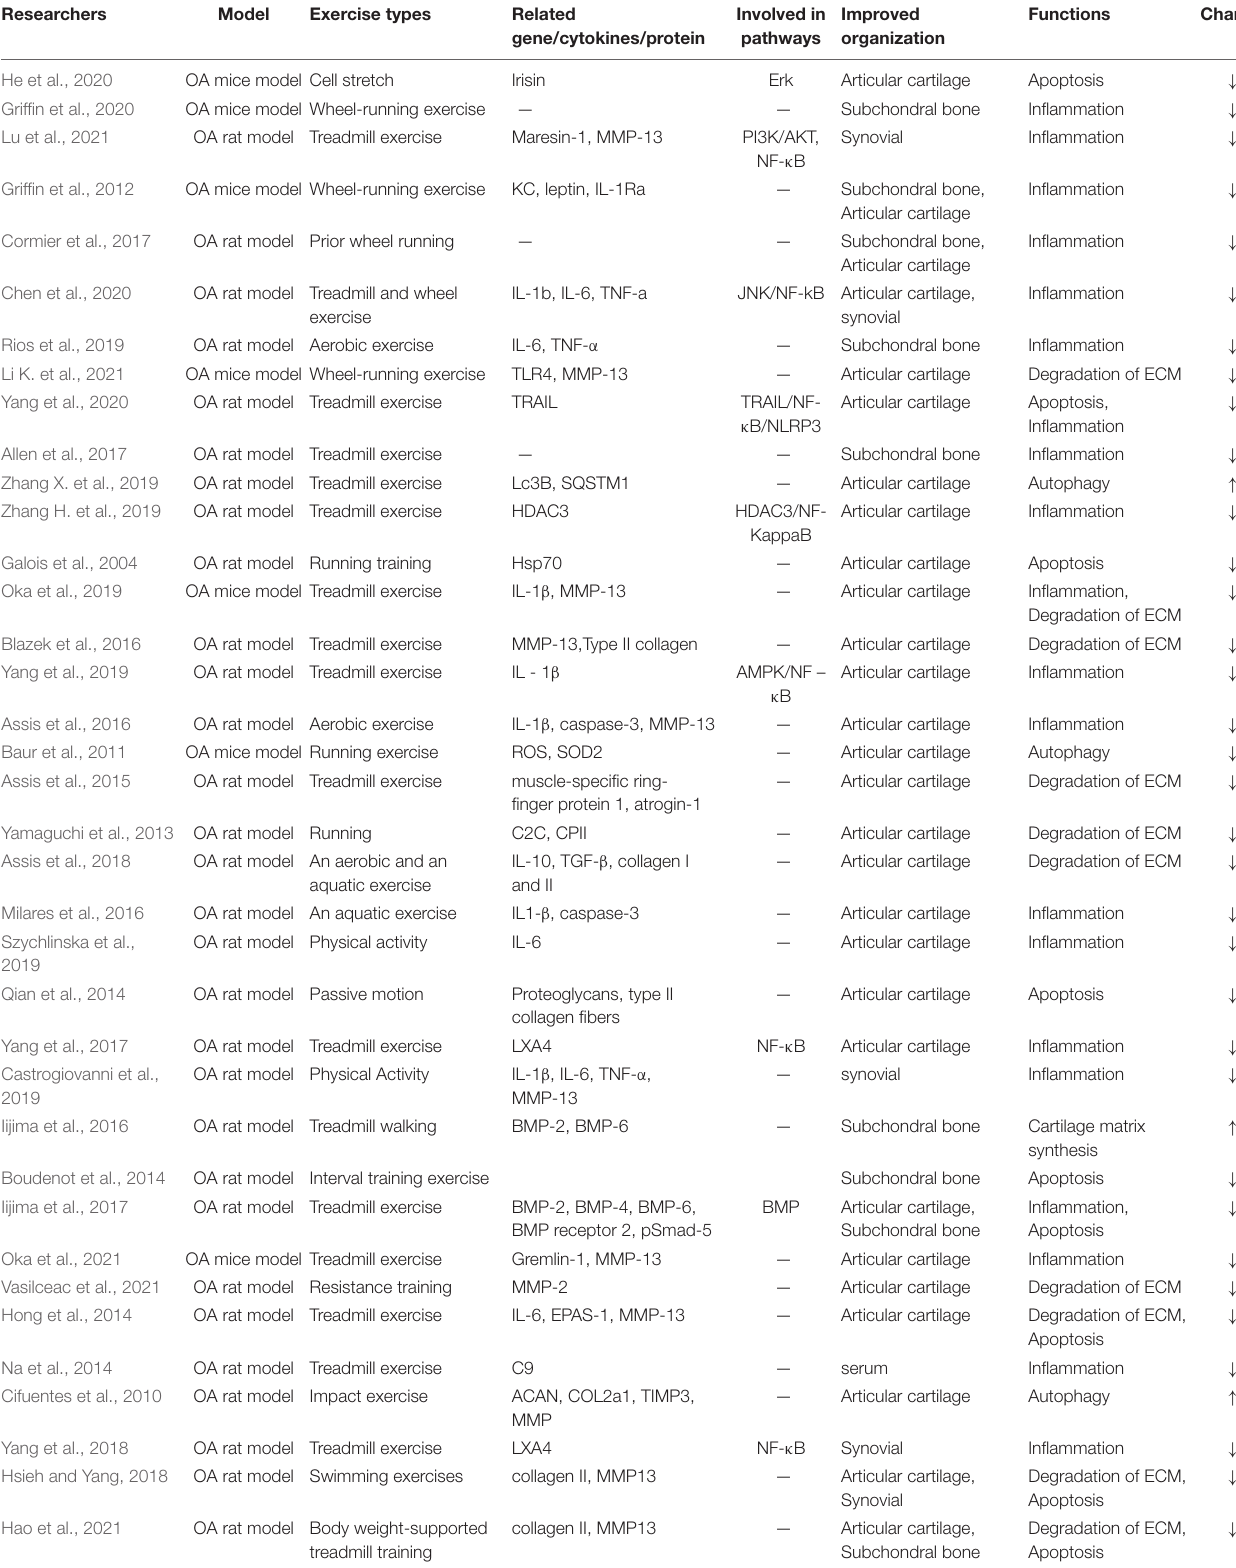
TABLE 1 | Mechanism of exercise in the treatment of Osteoarthritis